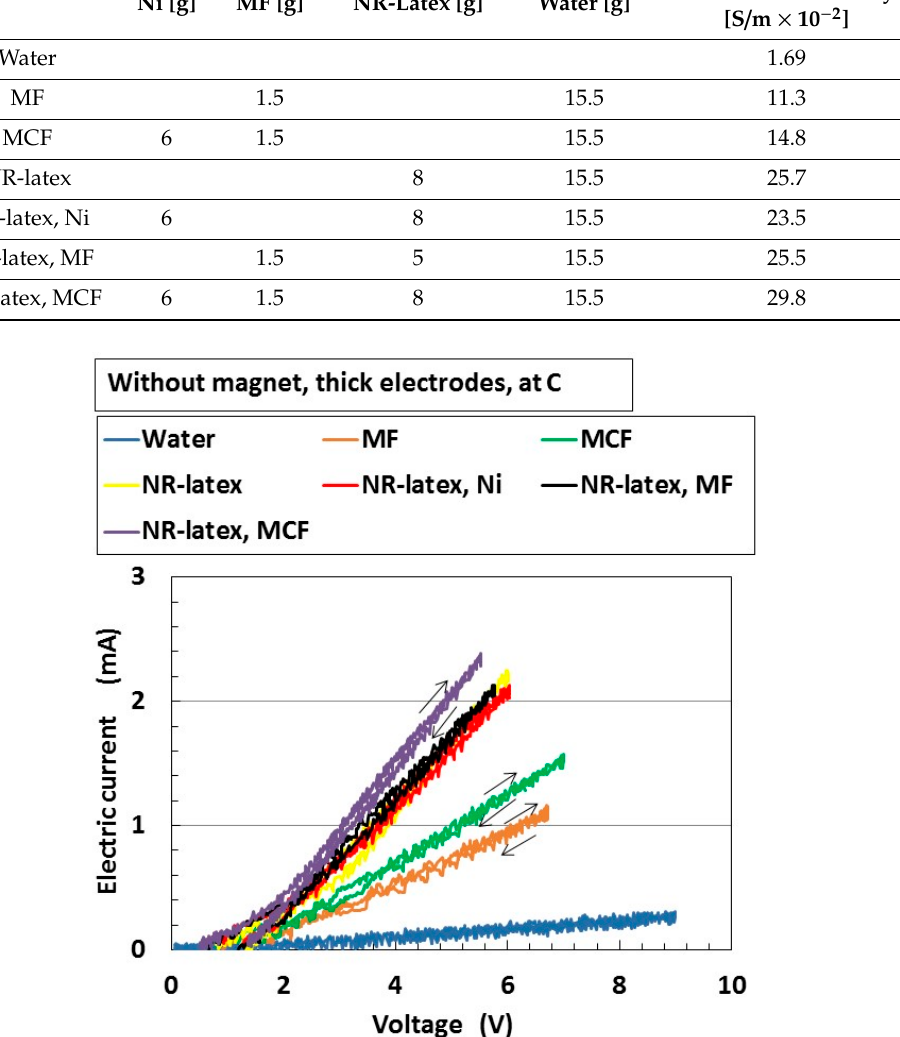
Table 1. Composition of liquids conducted on in the present experiment. MF: Magnetic field; NR: Natural rubber.